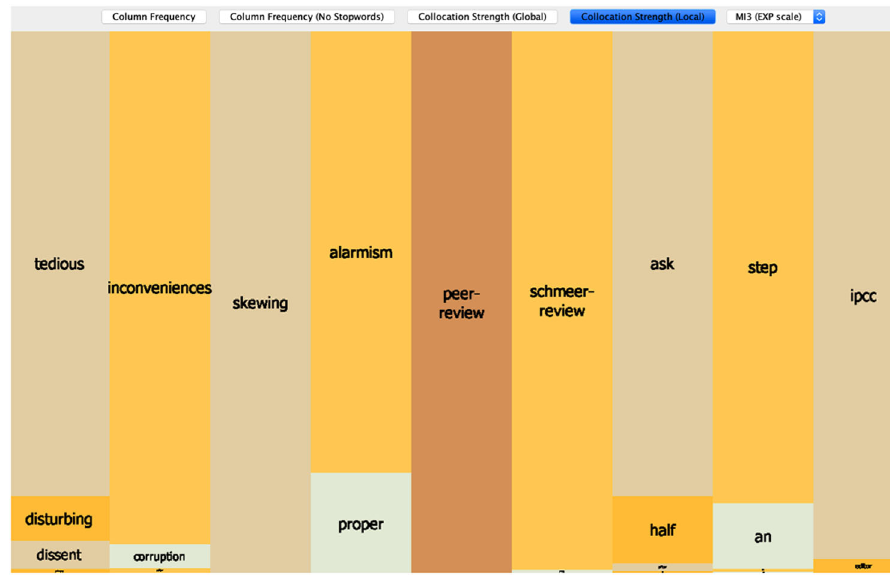
Fig. 7 Mosaic visualization of peer review in CSBC-CON (7 lines). Collocation strength: Local, MI3 (EXP Scale).